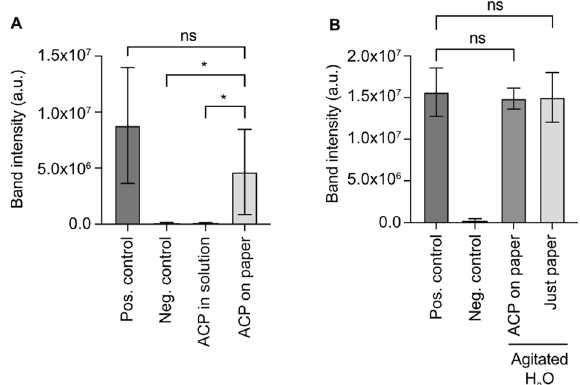
Figure 2. Nitrocellulose-bound ACP. ( A ) Densitometric analysis of gel electrophoresis results of Fig. S1. While ACP in solution inhibits RPA completely, undisturbed nitrocellulose-bound ACP does not significantly affect RPA (n = 5 for all conditions, unpaired t-test, mean with SD). ( B ) Densitometric analysis of gel electrophoresis results of Fig. S2. Agitation of nitrocellulose-bound ACP in water did not release enough ACP to significantly inhibit RPA (after the removal of the nitrocellulose, the water was used in the RPA). Furthermore, water in which plain nitrocellulose was agitated, does not significantly inhibit RPA either (n = 5 for all conditions, unpaired t-test, mean with